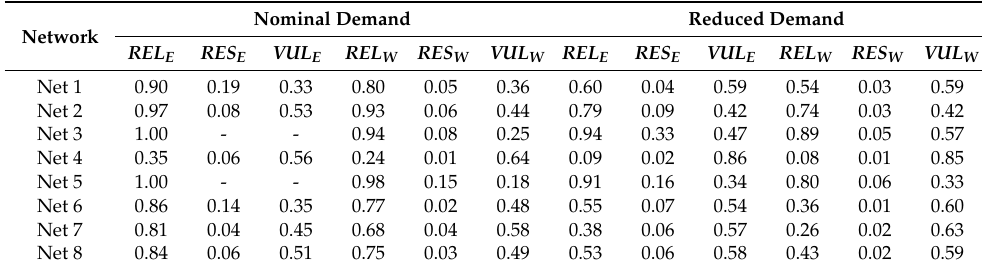
Table 13. Performance metrics